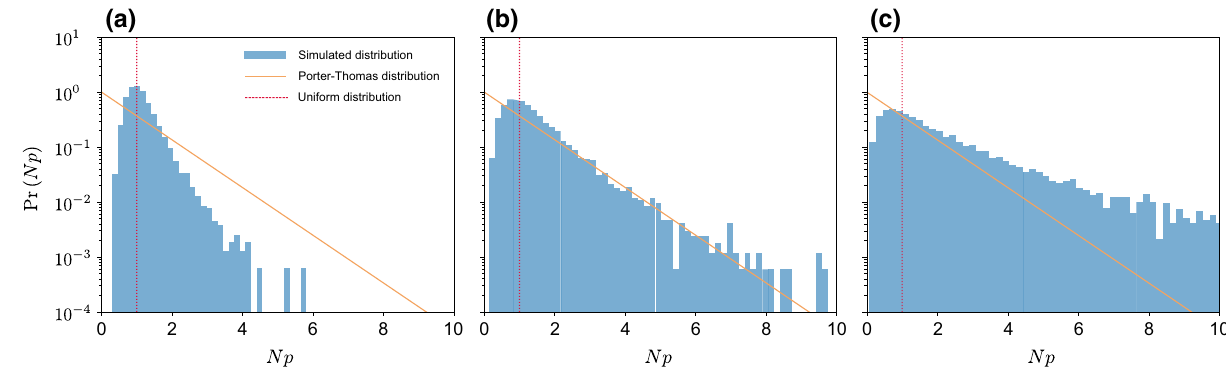
FIG. 9. The output probability distribution for dynamic sampling of random Hamiltonian evolution. (a)–(c) The plots represent the rescaled probability distributions obtained by sampling at k times. The simulations comprise a five-qubit environment interacting with a single-qubit system. The sampling times vary from k = 5 on the left, to k = 15, and to k = 35 on the right. The orange line represents the ideal Porter-Thomas distribution Pr ( Np ) = e − Np and the red dashed line is the uniform distribution δ( p − 1 / N )